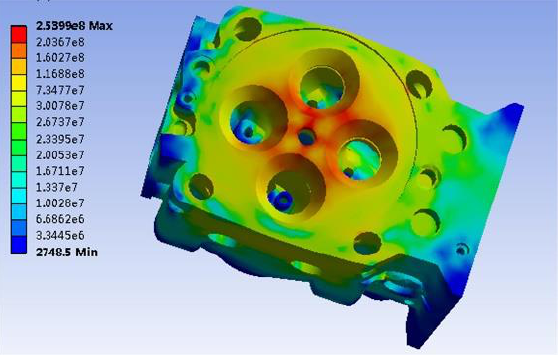
Figure 12. Contour map of the cylindrical head’s thermo-mechanical coupling stress.